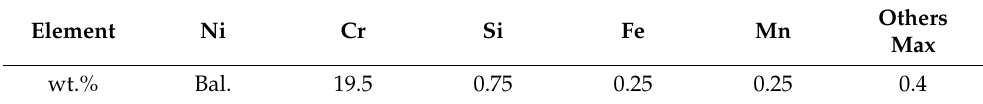
Table 2. Chemical composition of Ni-20Cr alloy (Amdry 4535).